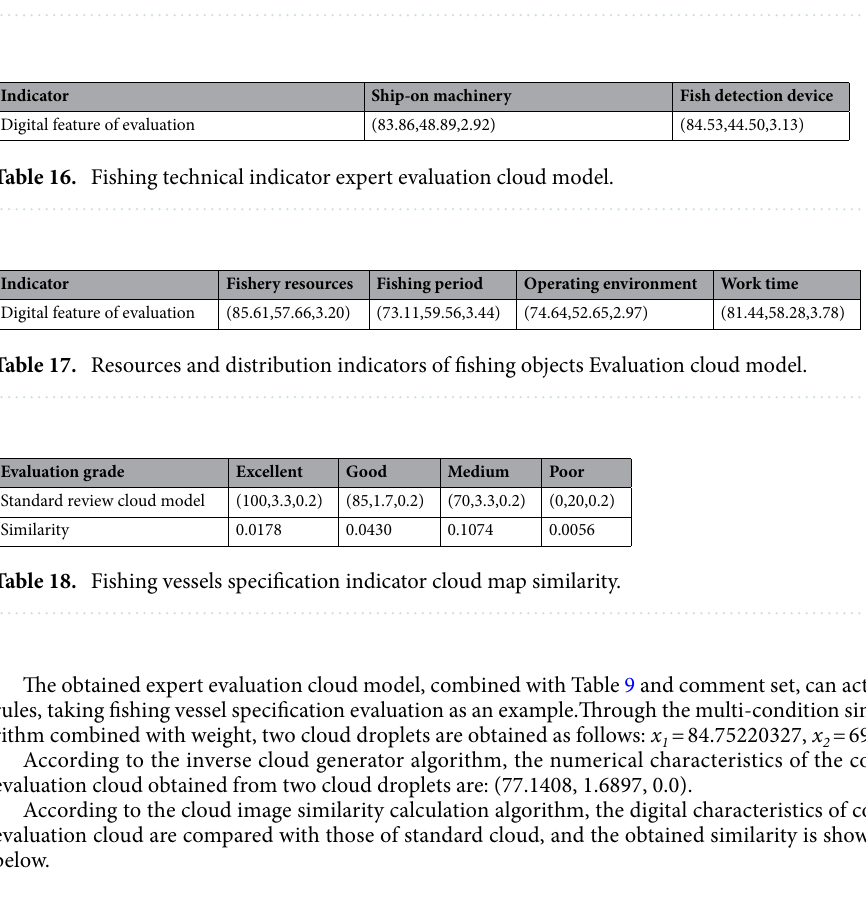
Table 15. Net tare expert evaluation cloud model.